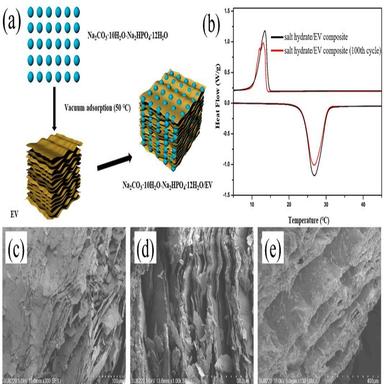
(a) schematic illustration of vacuum impregnation for preparing Na2SO4⋅10H2O-Na2CO3⋅10H2O/EV composite PCM, (b) DSC curves of Na2SO4⋅10H2O-Na2CO3⋅10H2O/EV composite PCM before and after 100 thermal cycles, and SEM images of (c) RV; (d) EV; (e) Na2SO4⋅10H2O-Na2CO3⋅10H2O/EV composite PCM Reproduced with the permission of Elsevier.